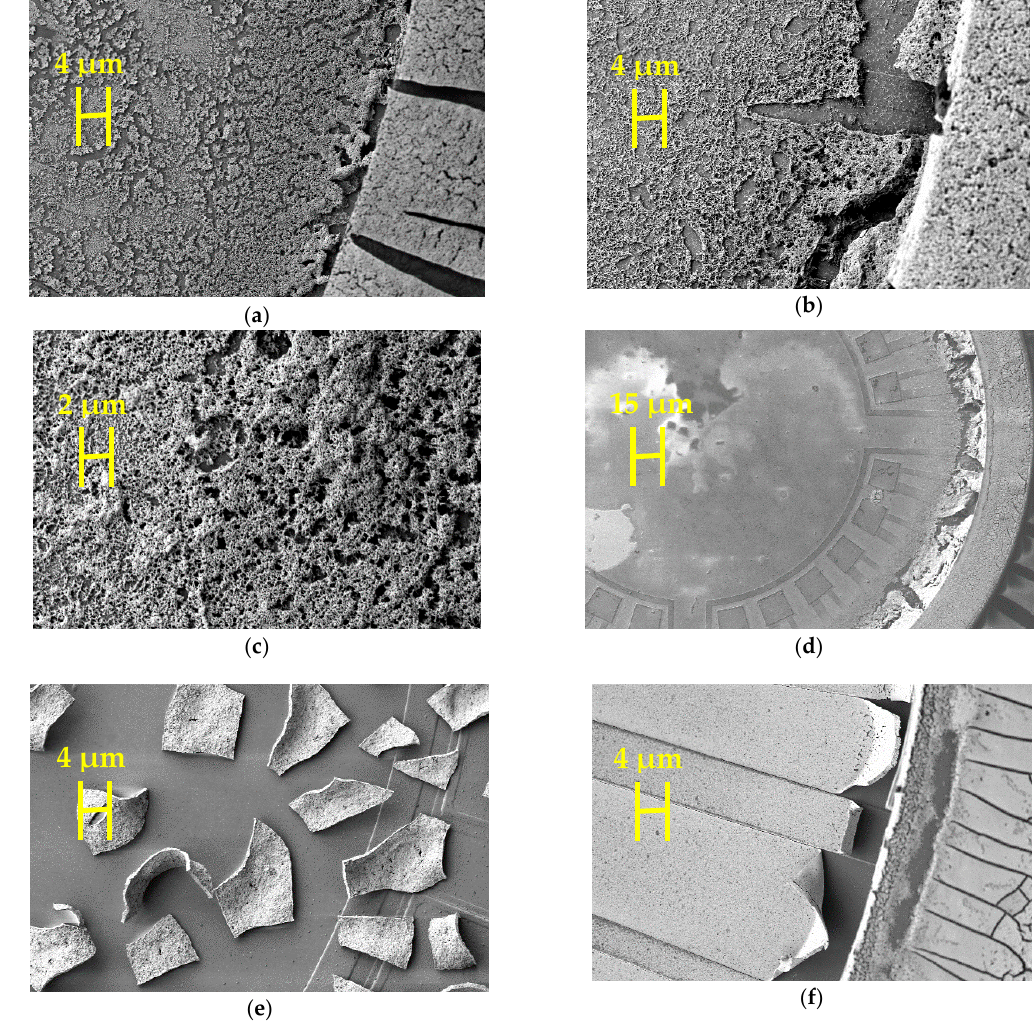
Figure 14. SEM image showing the condition of the catalyst after 72 h test (combination of three 24 h